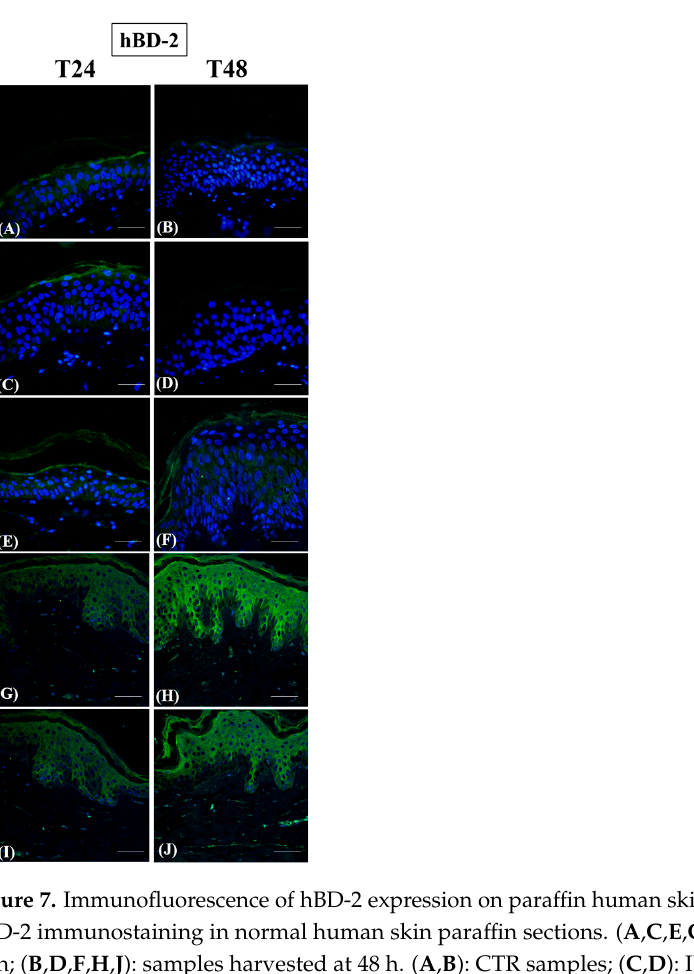
Figure 6. Quantitative analysis of TLR2 and TLR 4 epidermal distribution after immunofluorescence analysis after 24 and 48 h of cytokine incubation. ( A ): TLR2; ( B ): TLR4. TLR2: Toll-like receptor 2; TLR4: Toll-like receptor 4; IL-4: interleukin 4; IL-13: interleukin 13; IL-22: interleukin 22; IL-23: interleukin 23. Statistical analysis was performed by Prism 9.0.0 via Kruskal–Wallis non-parametric analysis of variance, followed by Dunn’s post-hoc multiple comparison test. Differences were considered statistically significant when p < 0.05. * p < 0.05; *** p < 0.01.